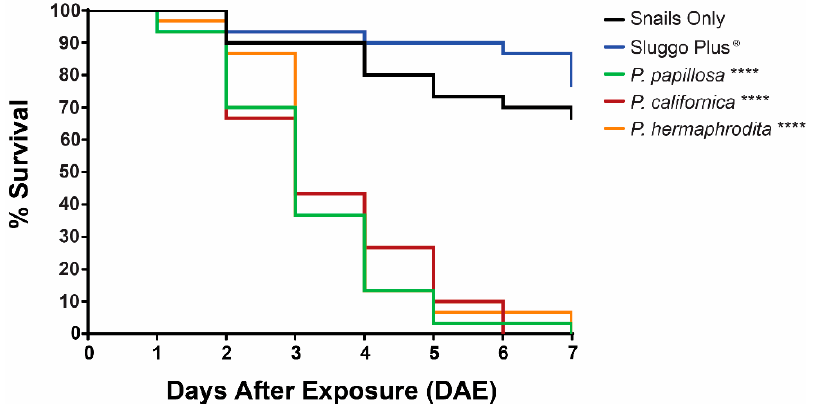
Figure 2. Kaplan-Meyer Graph indicating the percent survival of Succinea snails treated with the recommended dose (30 IJs/cm 2 ) of Phasmarhabditis papillosa (green), Phasmarhabditis californica (Red), Phasmarhabditis hermaphrodita (Orange), the molluscicide Sluggo Plus ® (Blue), or the control treatment with Succinea snails only (Black), over the course of 7 days. **** indicates a p value of less than 0.0001 when compared to the control treatment.